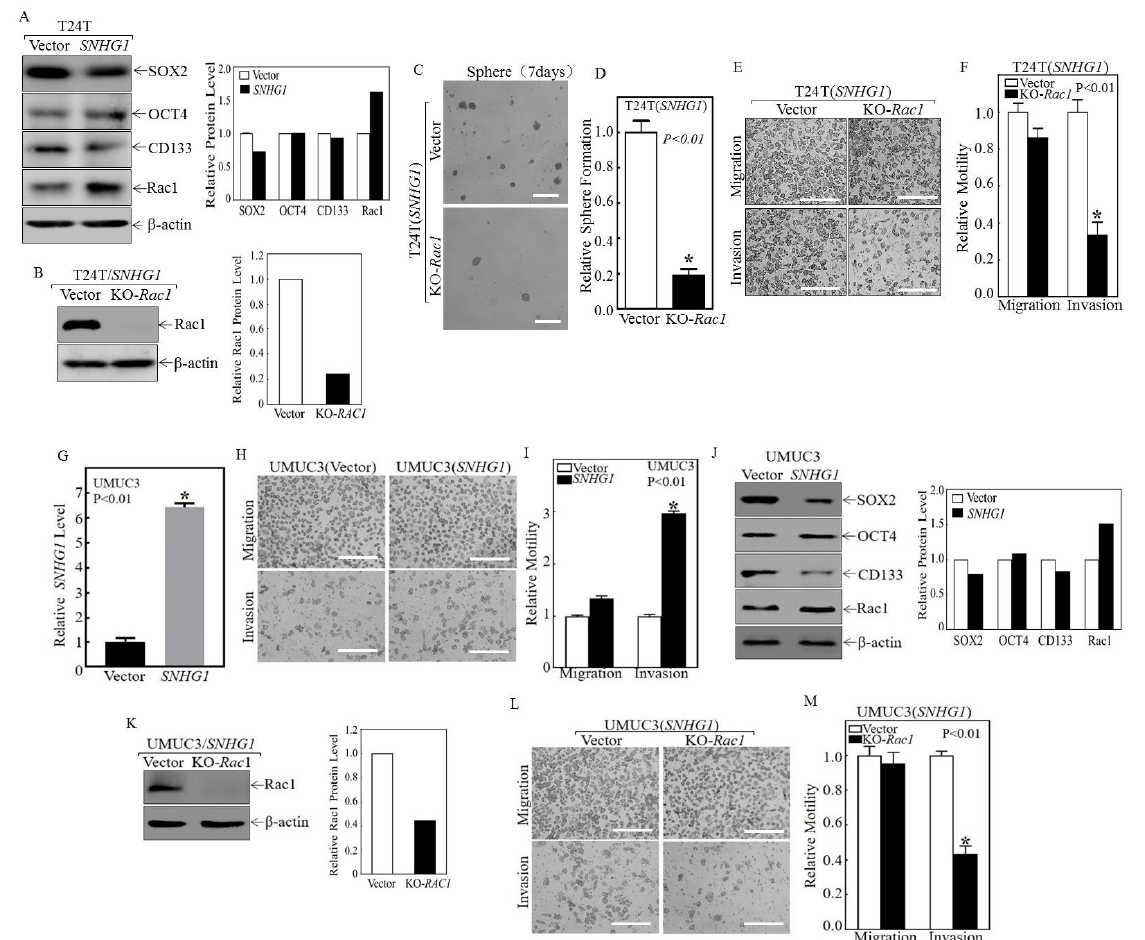
Figure 2. SNHG1-induced stem-cell-like and invasive behaviors were mediated by the upregula- tion of Rac1 in both T24T and UMUC3 cells. ( A , Left panel) Total protein extracts from cultured T24T(Vector) and T24T(SNHG1) cells were subjected to Western blotting using antibodies against SOX2, OCT4, CD133, and Rac1. β -Actin served as a loading control. ( A , Right panel) Relative protein levels determined by densitometry and expressed as ratios versus β -Actin. The uncropped blots and molecular weight markers of this figure and all other figures in this paper are shown in a Supplementary File S1 named “uncropped gel images”. ( B , Left panel) CRISPR/Cas9-Rac1 or its scramble vector was stably transfected into T24T(SNHG1) cells, and the transfectants were assessed by Western blotting for Rac1 expression. β -Actin was used as a protein loading control. ( B , Right panel) Relative protein levels determined by densitometry and expressed as ratios versus β